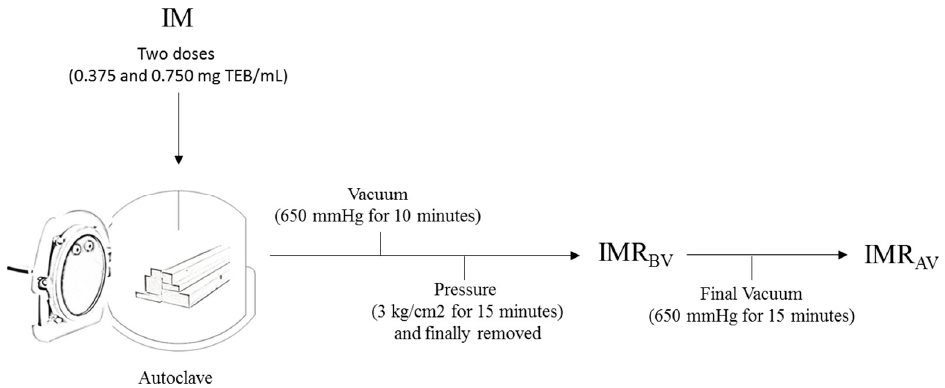
Figure 2. Flow chart representing the different steps of the impregnation process, and the different points in which the mixtures used for the quantification of the tebuconazole amount impregnated into the wood are recovered.